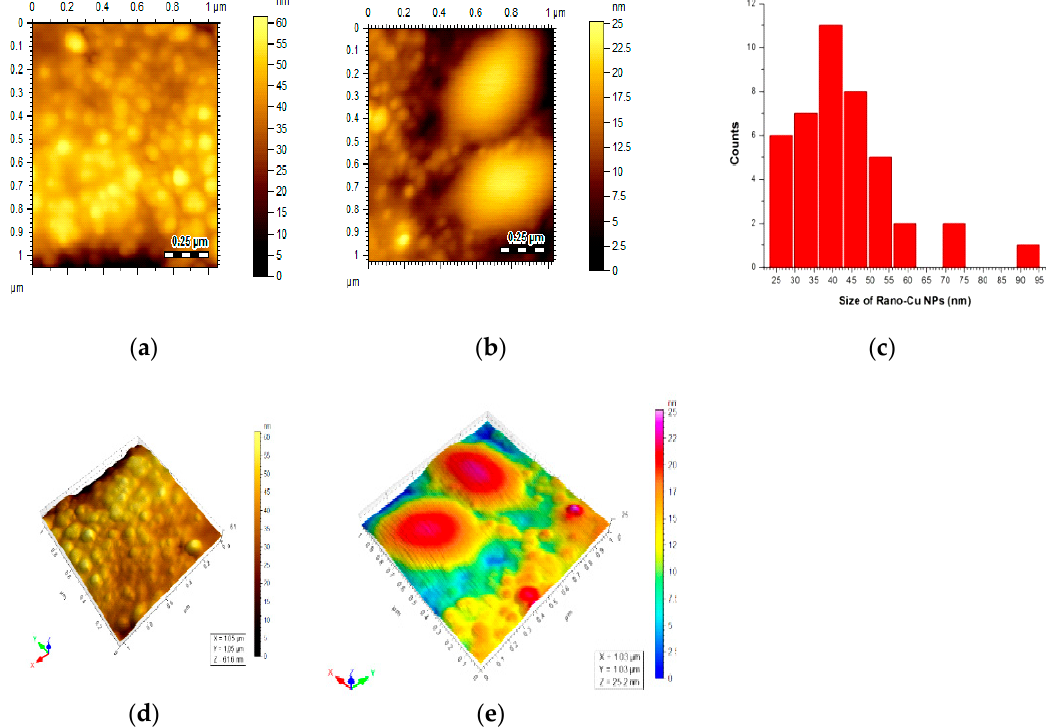
Figure 4. AFM image of ( a ) Rano-Cu NPs, ( b ) Rano-Cu NPs having 7-µM As 3+ , and ( c ) average size distribution bar diagram of Cu NPs ( a ) within the range of 22 – 95 nm. Parts ( d ) and ( e ) show the 3D topographical map of the ( a ) dispersed and ( b ) aggregated surface of Cu NPs.